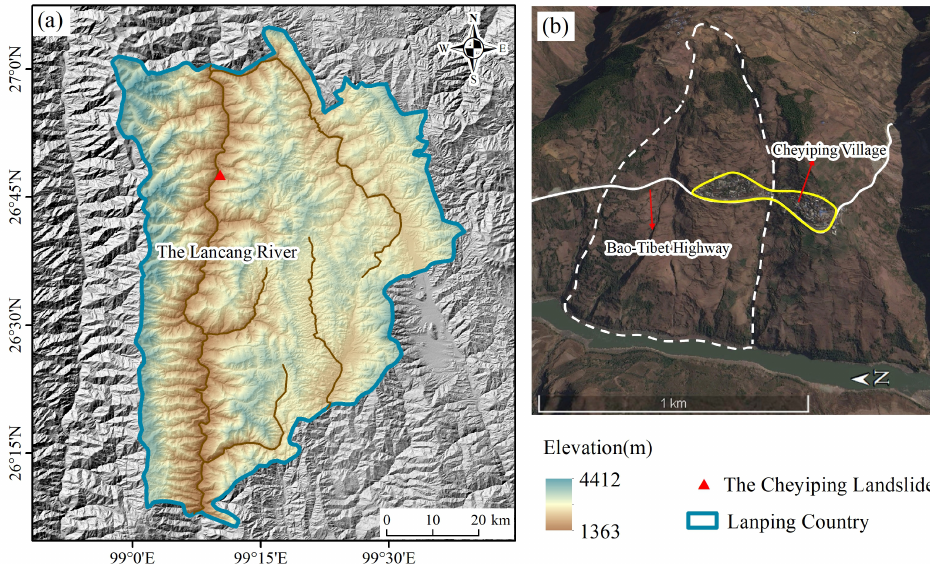
Figure 1. Overview of the study area. ( a ) The geographical location of the Cheyiping landslide (the red triangle). ( b ) The Google map of the Cheyiping landslide, labeled with Bao–Tibet highway, Cheyiping village, and the boundary of the Cheyiping